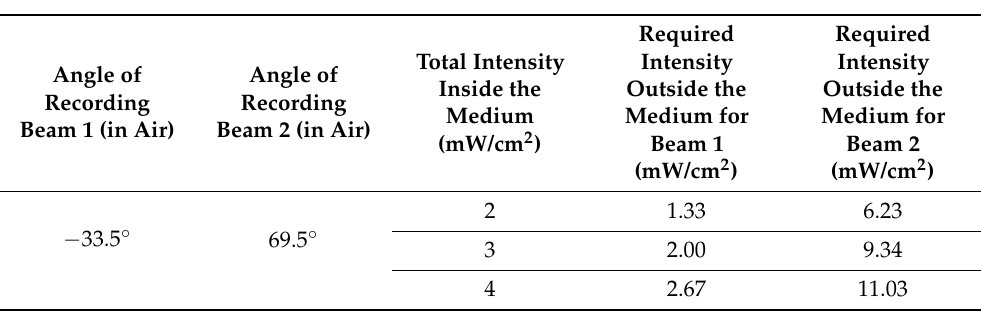
Table 1. Recording intensities for the beams incident on the photopolymer calculated to compensate for reflection losses and obliquity at the recording angles for a HOE designed for − 45 ◦ incidence in air diffracted to a +45 ◦ angle inside the medium (for a 633 nm operating wavelength) for a 1:1 beam ratio inside the